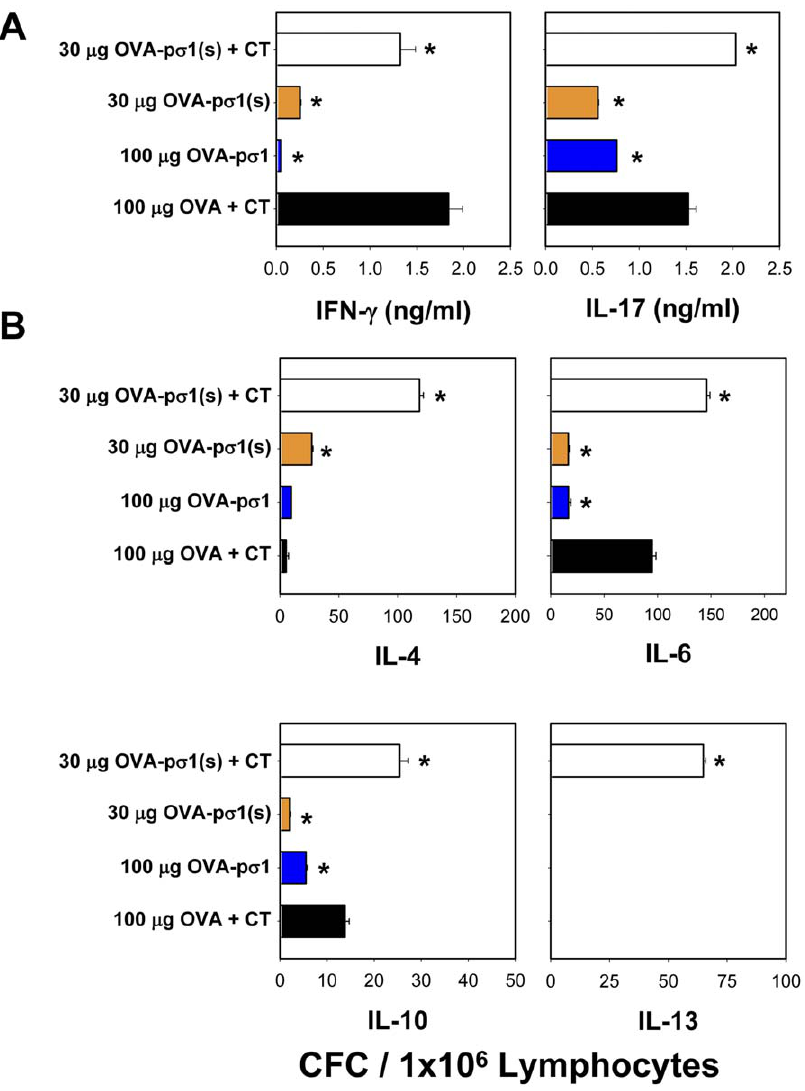
Figure 8. Nasal OVA-p s 1(s) stimulates mixed Th cell responses. OVA-p s 1(s) plus cholera toxin (CT) enhances splenic OVA-specific Th2 and Th17 cell responses when compared to mice nasally immunized with OVA-p s 1(s) alone, OVA-p s 1 alone, or with OVA plus CT-immunized mice. On day 24 post-primary immunization, CD4 + T cells were isolated and cultured in the presence of OVA or media for 2 days, and subsequently assessed for A. IFN- c and IL-17 production by ELISA and B. IL-4, IL-6, IL-10, and IL-13 cytokine-forming cell (CFC) responses by T cell ELISPOT. Depicted are the means (corrected for media values) 6 SEM of two experiments: * P , 0.001 versus OVA plus CT-immunized mice.